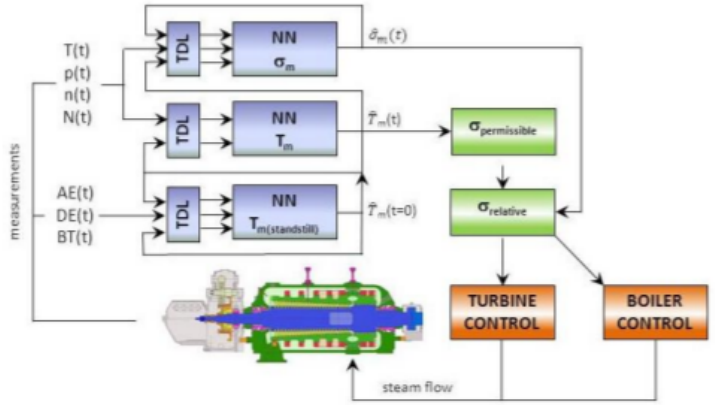
Figure 2: NARX neural network based steam turbine thermal stress control. Designations: NN - neural network, TDL - tapped delay inputs, Tm - rotor critical point metal temperature during turbine load cycle, m - rotor critical point stress during turbine load cycle, Tm (standstill) - rotor critical point metal temperature during turbine standstill period, T(t),p(t) - steam temperature and pressure before HP turbine con- trol valve, n(t) - steam turbine speed, N(t) - steam turbine load, AE(t) - steam turbine absolute expansion, DE(t) - steam turbine differential